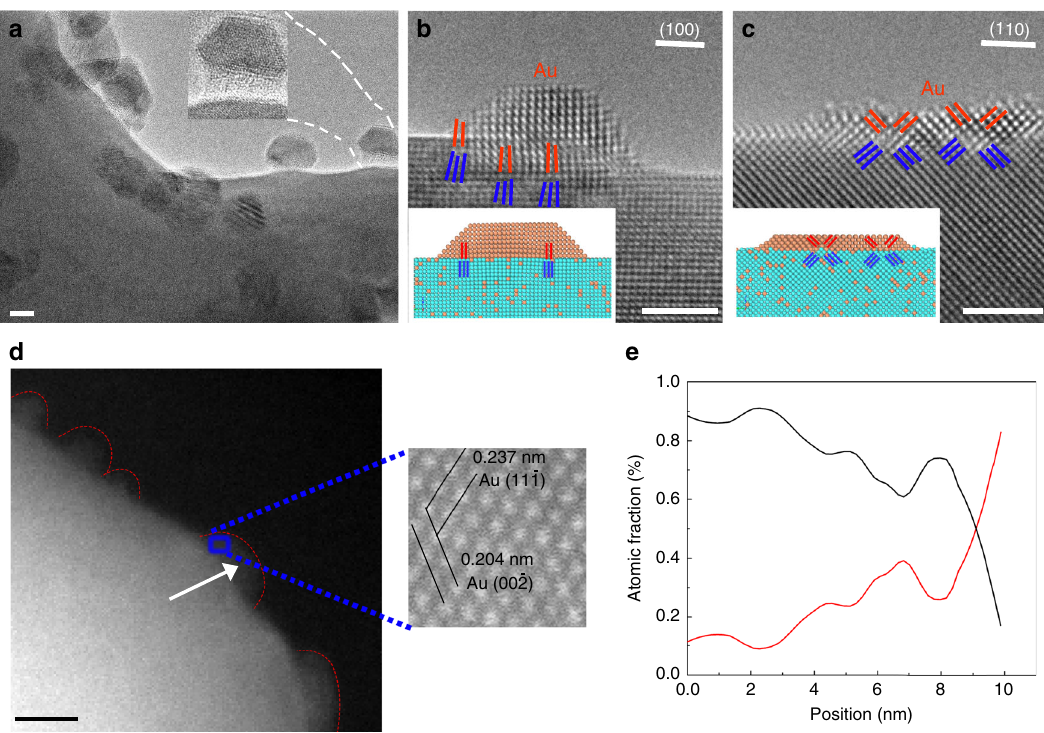
Fig. 1 Phase separation and clustering of Au atoms in Cu – Au solid solution. a TEM image of the Cu-10%Au thin fi lm annealed at 600 °C and 1 × 10 − 3 Torr of H 2 gas fl ow, the inset is a zoom-in view of a circled cluster. The inset is a zoom-in view of the cluster revealing that its inner part of the cluster is in an amorphous state. b c Equilibrium Au clusters on the (100) and (110) surfaces of the Cu(Au) solid solution. The lattice mismatch at the Au/Cu(Au) interface is marked by red and blue lines of the (200) atomic planes of the Au clusters and Cu(Au) substrate, respectively. Insets show schematically the lattice-mismatched Au clusters with the substrate. d Low-magni fi cation HAADF-STEM image showing the formation of Au clusters (as marked by dashed lines) along a hole edge. The enlarged view is an atomically resolved HAADF-STEM image obtained from the cluster marked by the blue rectangle box. e STEM-EDS linescan along the arrow indicated in ( d ), con fi rming the high content of Au in the cluster. Scale bar, 5 nm ( a , d ), 2 nm ( b , c ).